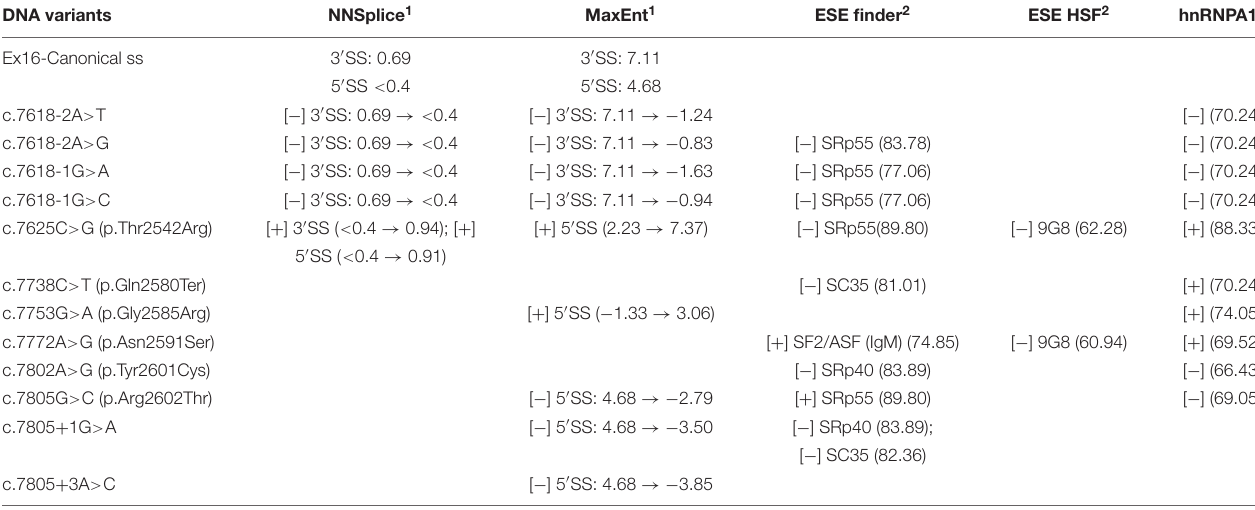
TABLE 2 | Bioinformatics analysis of potential splicing variants of BRCA2 exon 16. DNA variants NNSplice 1 MaxEnt 1 ESE finder 2 ESE HSF 2